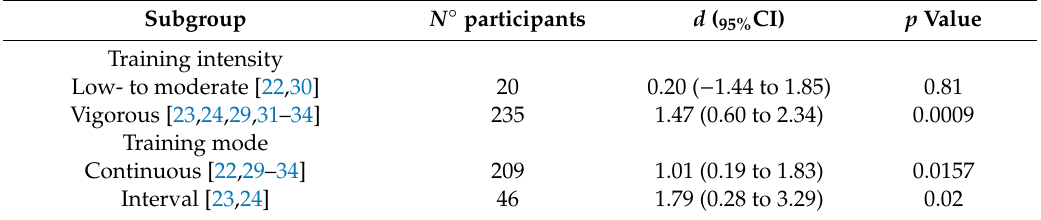
Table 2. E ff ects of training intensity and training mode on the maximum oxygen consumption (VO 2max ) compared to usual care (no exercise) subgroup analyses.